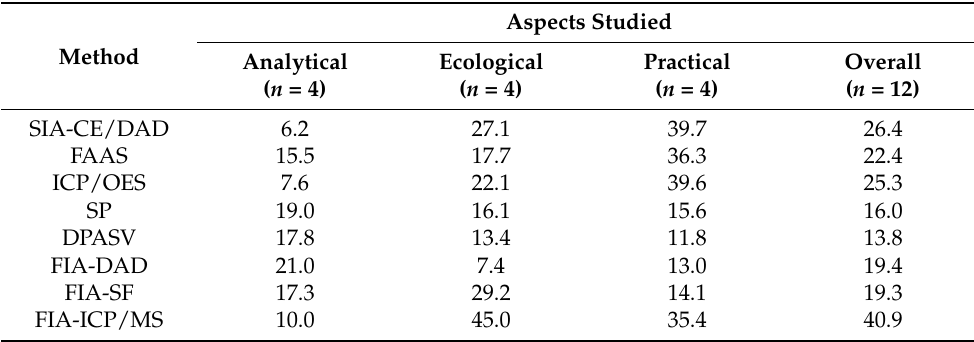
Table 5. The variance of assessments expressed as RSD (%) of the main assessment outcomes, presented for the individual methods.